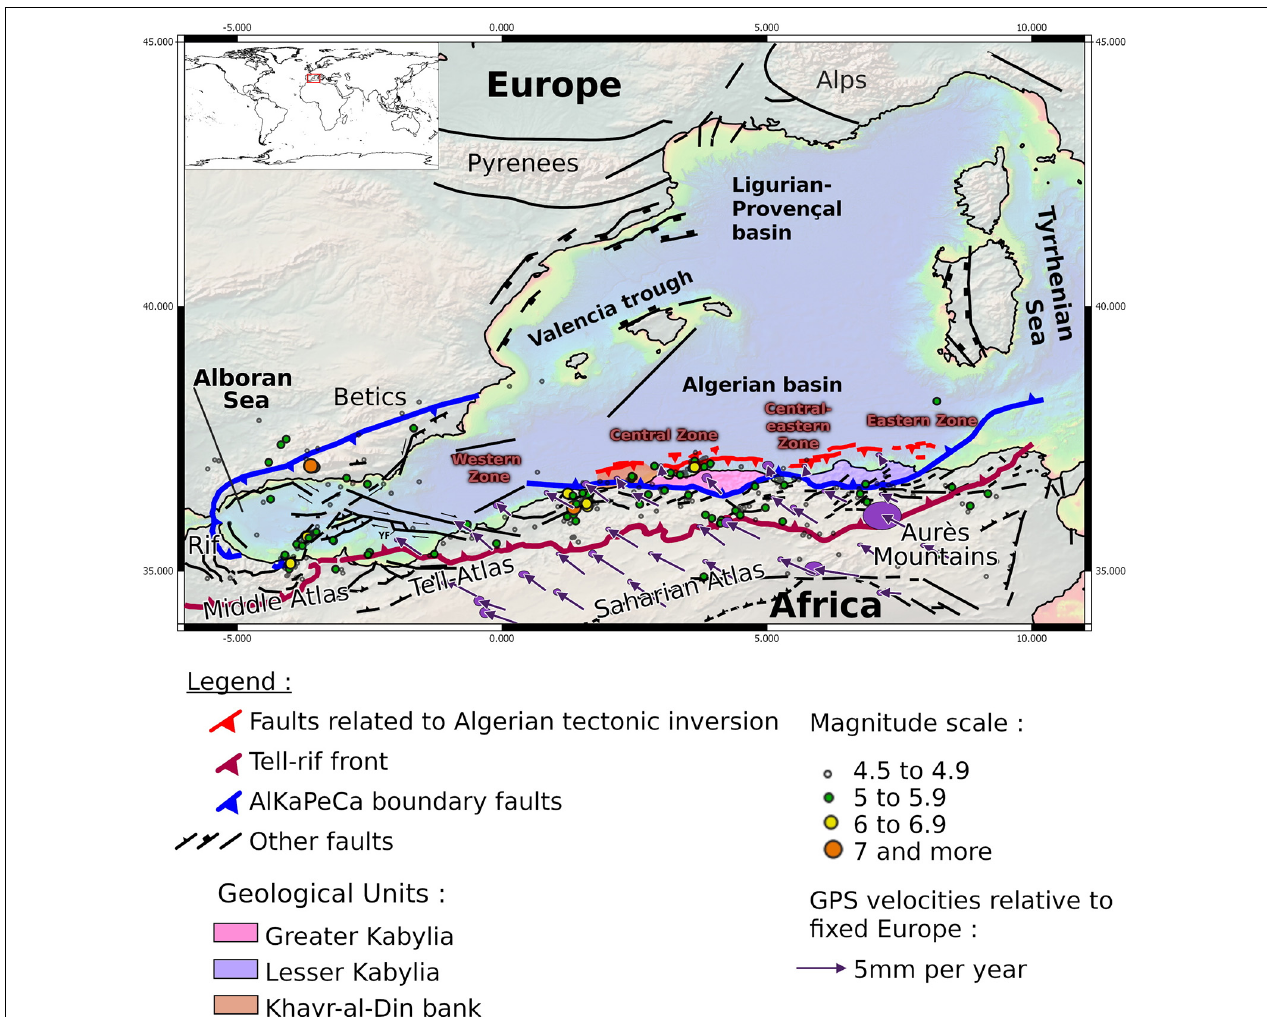
FIGURE 1 | Simplified tectonic sketch of the south-western Mediterranean basins and margins. Blue lines represent the limit between internal and external zones and dark-red lines is the Tell-Rif front. Bright-red lines is a schematic representation of subsurface active faults, redrawn after Yelles-Chaouche et al. (2006), Cattaneo et al. (2010), Giaconia et al. (2015), Rabaute and Chamot-Rooke (2015), Soumaya et al. (2018), and Gaidi et al. (2020). GPS vectors and their associated errors are taken from Bougrine et al. (2019). Circles are M > 4.5 earthquakes taken from the U.S. Geological Survey (2021). YF marks the position of the Yusuf Fault, a notable structure that accommodates the deformation at the transition between the Alboran and the Algerian basins. See text for